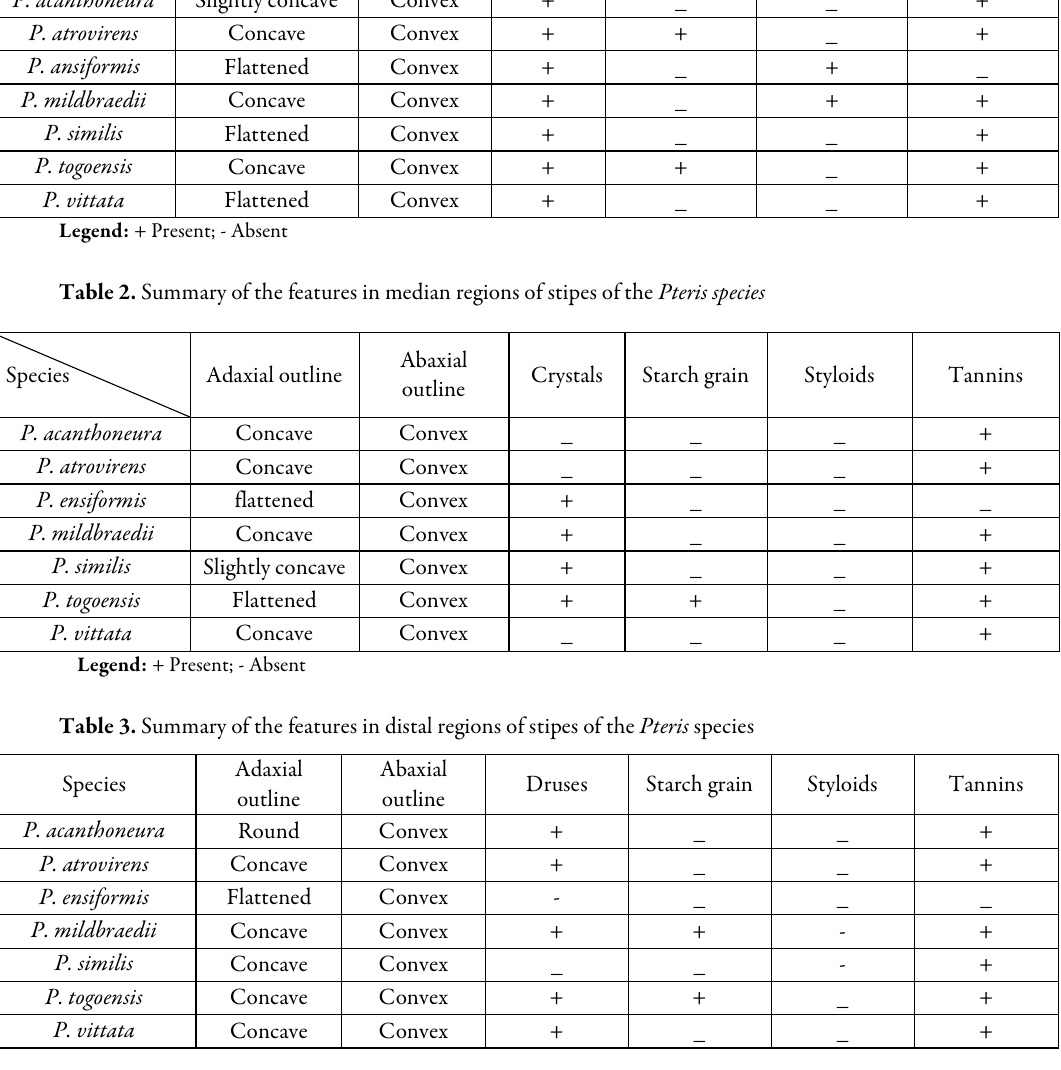
Table 1 . Summary of the features in proximal regions of stipe of the Pteris species Species